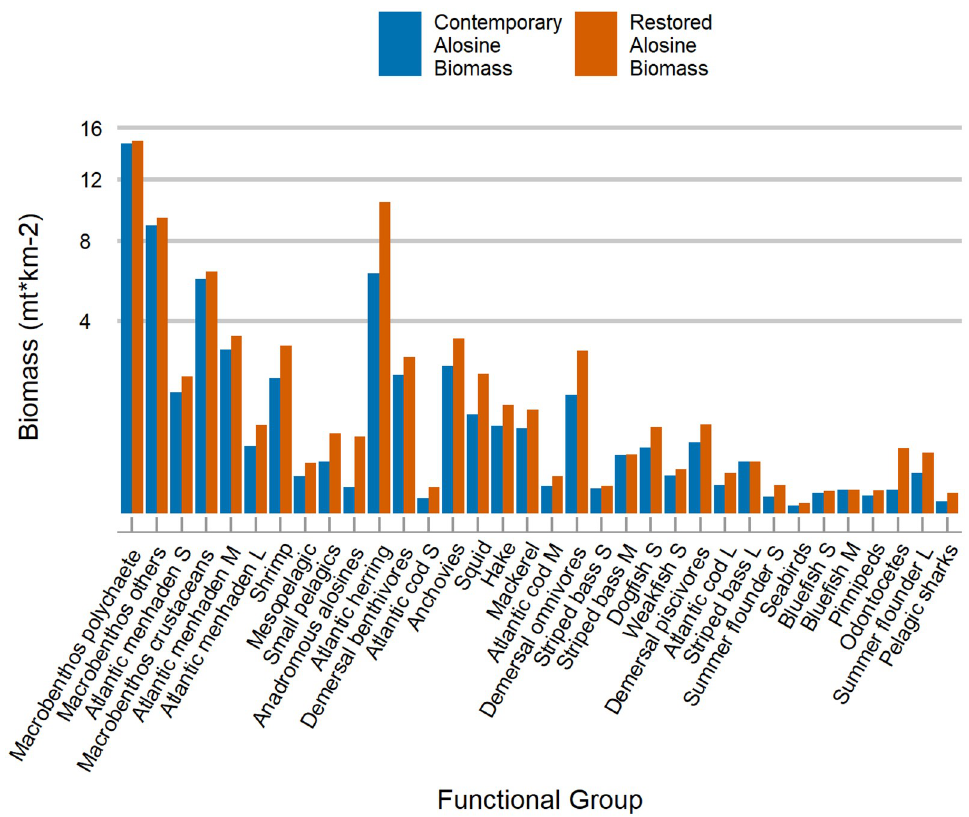
Fig 3. Comparing biomass of functional groups benefiting from alosine restoration. Contemporary and restored biomass for all functional groups impacted by alosine biomass restoration. The y-axis was square transformed to show differences for functional groups with low biomass. Groups that presented biomass change less than to 0.002 mt.km -2 were dropped from the graph. Age groups are represented by size, as small (S), medium (M), and large(L).